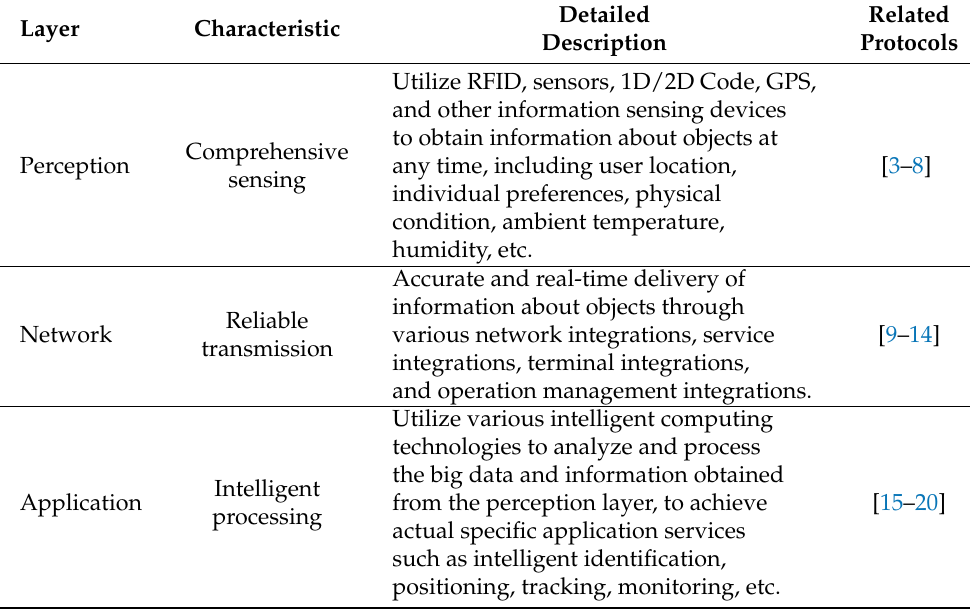
Detailed Description